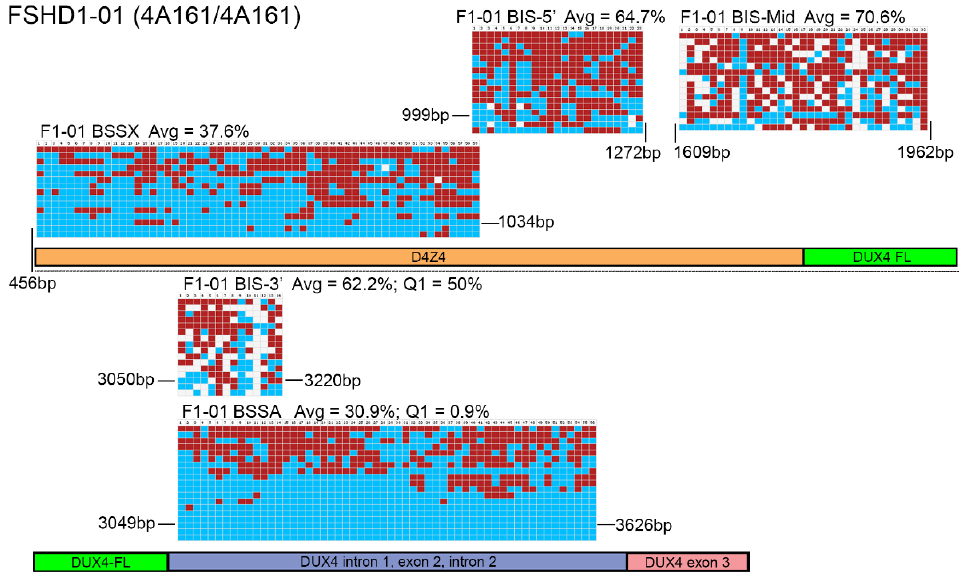
Figure 3. BSS analysis comparison of FSHD1 epigenetic signatures. BS-converted DNA from a genetically confirmed FSHD1 subject (F1-01) was analyzed using the BSSA, BSSX, BIS-5′, BIS-Mid, and BIS-3′ assays. Each BS graphic representation is shown approximately where it aligns with each part of the 4q35 D4Z4 array including the D4Z4 (orange), DUX4-fl ORF (green), DUX4 Intron 1, Exon 2, Intron 2 (purple), and Exon 3 (pink), with exact location indicated by base pairs (bp) downstream from the Kpn I site of the distal D4Z4 RU. Blue boxes indicate unmethylated CpGs, red boxes indicate methylated CpGs, and white boxes indicate no CpG where one is expected. Average methylation percentages are denoted “Avg” and have values of 37.6% for BSSX, 64.7% for BIS-5′, 70.6% for BIS- Mid, 62.2% for BIS-3′, and 30.9% for BSSA. This FSHD1 subject has a haplotype of 4A161/4A161. Therefore, the diagnostic methylation percentages for the first quartile (Q1) are included for BSSA (0.9%) and BIS-3′ (50%) for comparison. Figure 4. BSS analysis comparison of FSHD2 epigenetic signatures. BS-converted DNA from a ge- netically confirmed FSHD2 subject (F2-02) was analyzed using BSSA, BSSX, BIS-5′, BIS-Mid, and